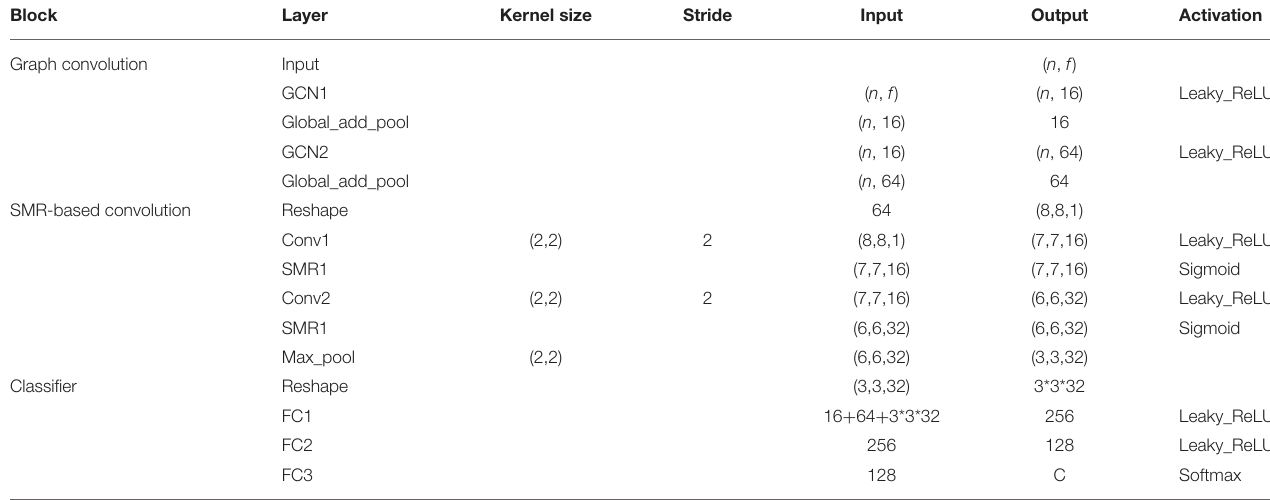
TABLE 1 | MDGCN-SRCNN architecture. Block Layer